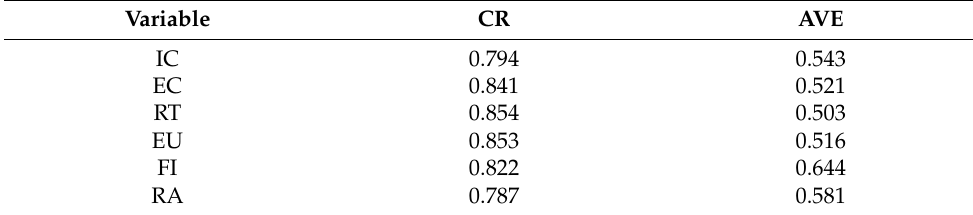
Table 4. Reliability and validity results.